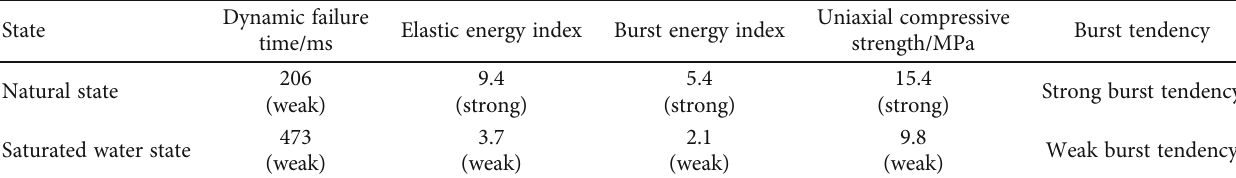
Table 6: The burst tendency test result of the No. 5 coal